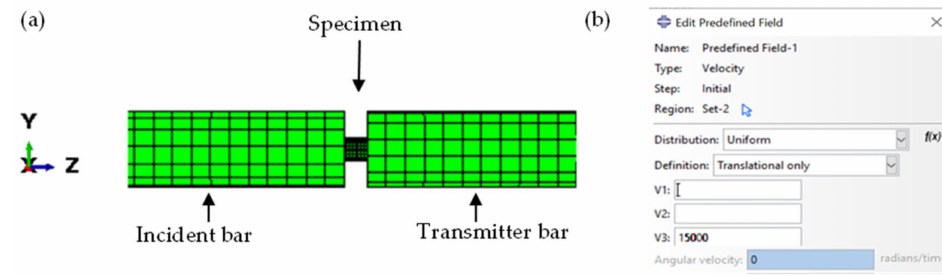
Figure 3. ( a ) A longitudinal section of a numerical model for the SHPB test and ( b ) the velocity (expressed in mm/s) in the predefined field imposed along the z -axis.